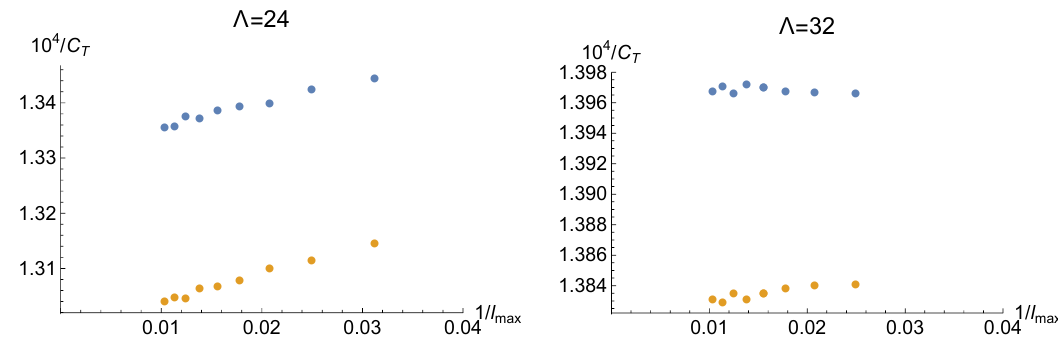
Figure 10 . The upper and lower bounds on the inverse central charge C (cid:0) 1 (cid:13)avor central charge C J is set close to saturating the lower bound, C J = (1 + 10 (cid:0) 4 ) min C J , for interacting theories with E 8 (cid:13)avor group, at derivative orders (cid:3) = 24 ; 32 and across a range of spin truncations ‘ max